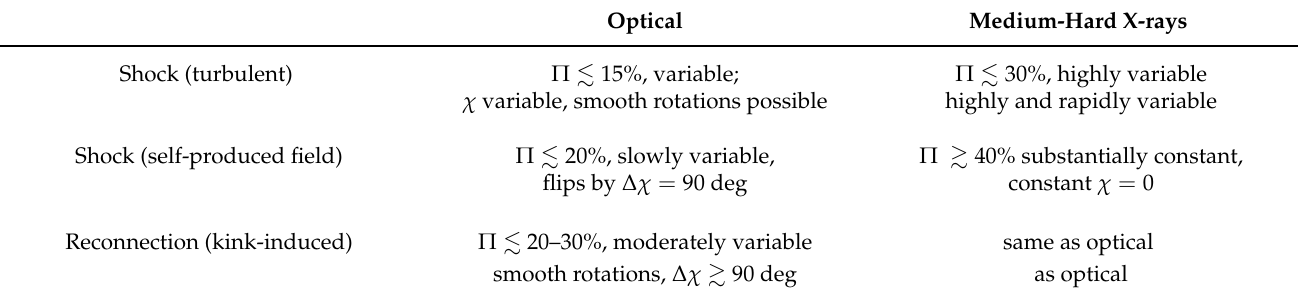
Table 1. Summary of predicted polarization features for some of the scenarios discussed in the text. Optical Medium-Hard X-rays Shock (turbulent) highly and rapidly